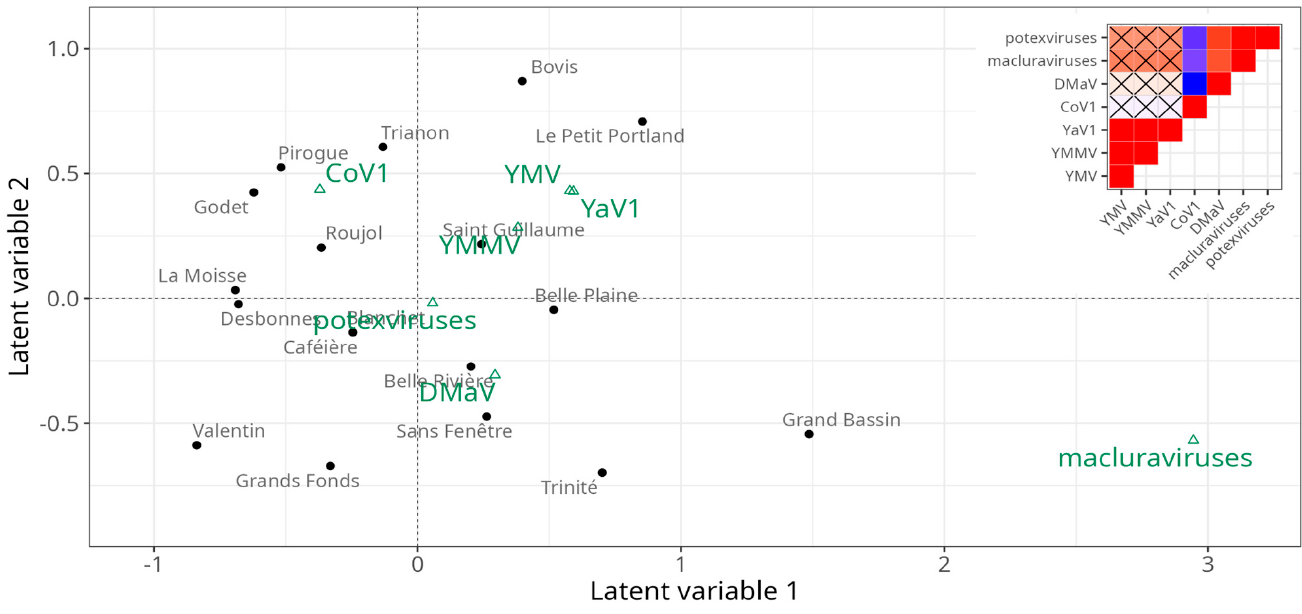
Figure 5. Ordination plot showing the position of yam viruses (green) and sampled field plots (dark grey) relative to the two first latent variables from the gllvm analysis. Elements that are close together on the ordination plot are statistically associated with each other. The diagram in the upper right corner shows the correlation matrix of the viruses, with blue representing negative correlation and red positive correlation between pairs of viruses. Non-significant correlations at the p = 0.05 threshold are marked with a cross sign.